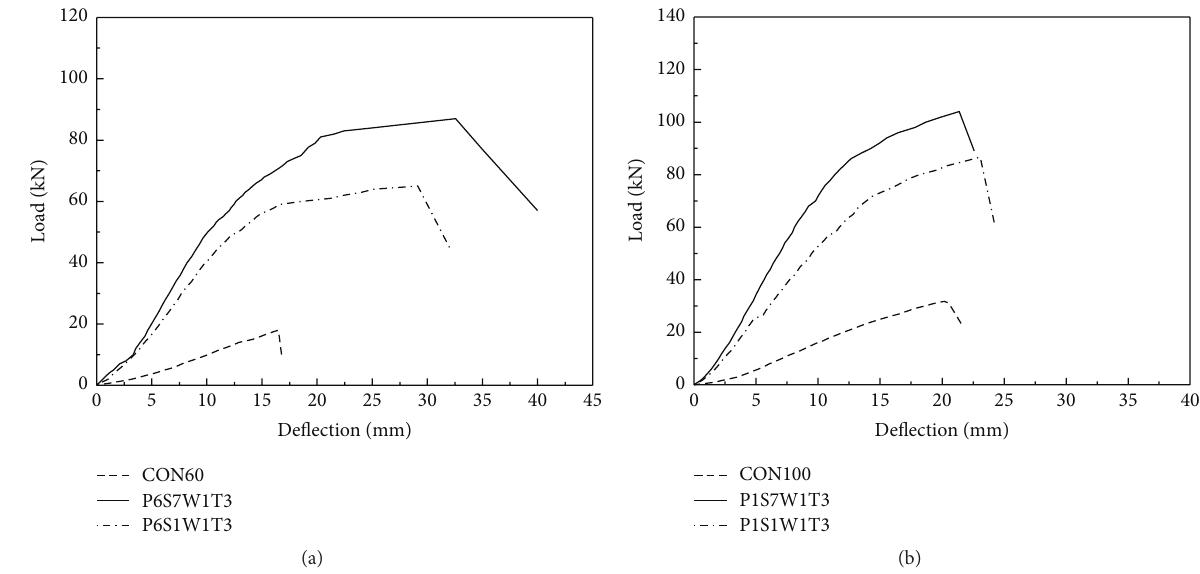
Figure 9: The influence of web spacing: (a) 𝑡 𝑠 = 3.2 mm, 𝜌 = 60 kg/m 3 , and 𝑡 𝑤 = 1.6mm and (b) 𝑡 𝑠 = 3.2 mm, 𝜌 = 100 kg/m 3 , and 𝑡 𝑤 =